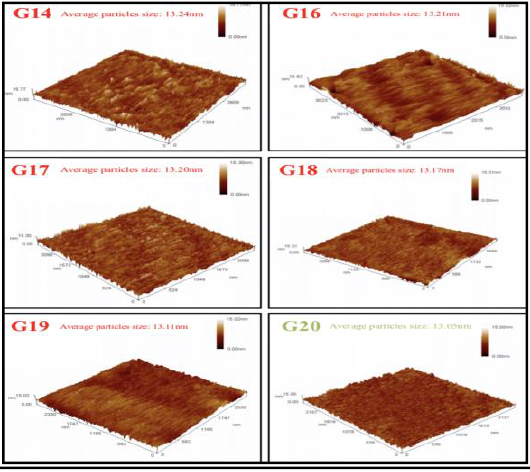
Figure 11. AFM 3D image of gold nanoparticles G14, G16-20